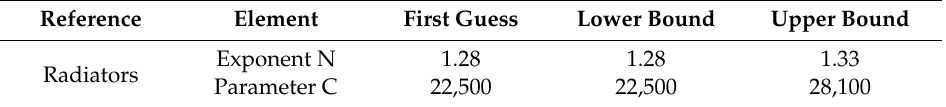
Table 8. Parameters collection for Calibration C.